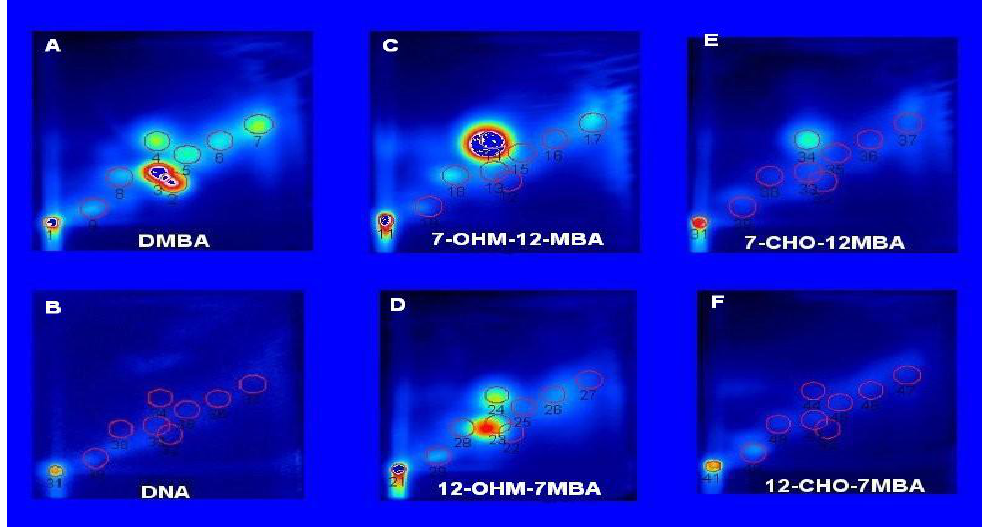
Figure 7: Autoradiogram of 32 P-postlabeled nuclease P1-treated DNA from photo-irradiation in the presence of (A) DMBA, (B) blank, (C) 7-HOCH CHO-12-MBA, and (F) 12-CHO-7-MBA in THF and calf thymus DNA by UVA light at a total dose of 14 J/cm 2 .